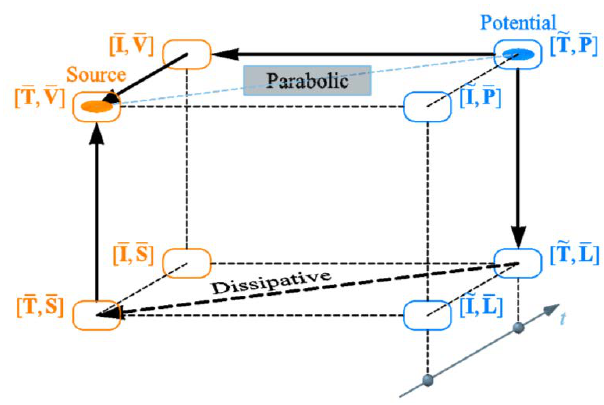
Figure 36: Parabolic equations in the classification diagram.